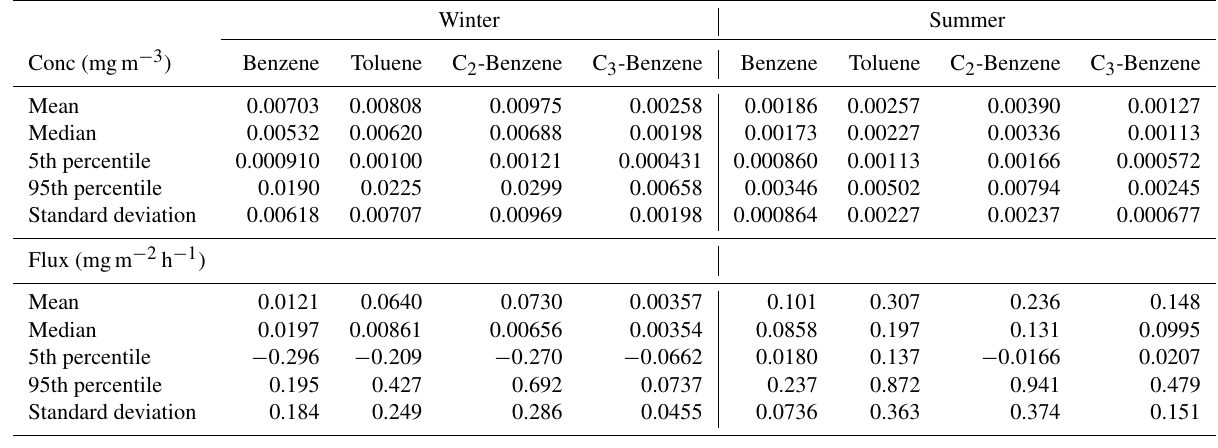
Table 2. Summary table for VOC concentrations and fluxes measured by PTR-ToF-MS. Data presented are for fluxes which are within 60% stationarity criteria for all u ∗ values.